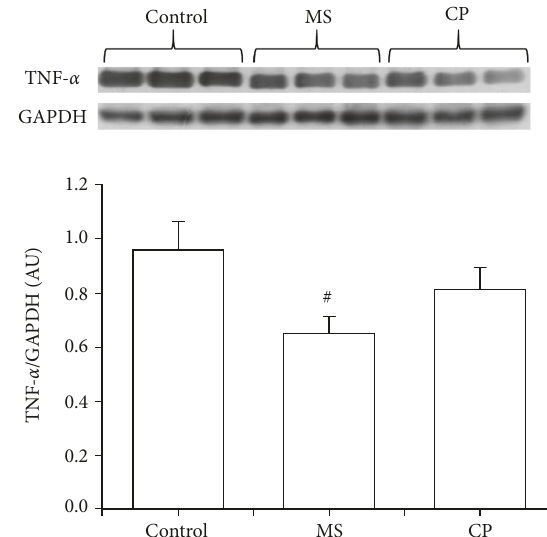
Figure 5: Expression of TNF α in aortas from control, MS, and CP rats. MS rats ingested sucrose solution during six months;